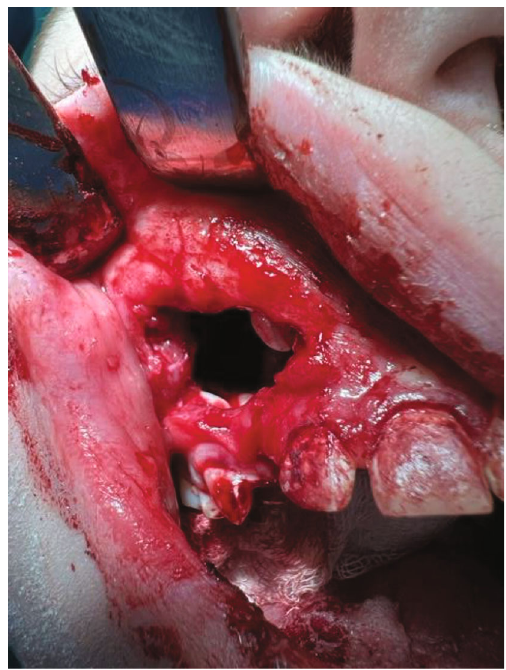
Figure 4: After incision and mucoperiosteal fl ap re fl ection, tooth 13 is visible. The anterior wall of maxillary sinus has been resorbed by the cyst.